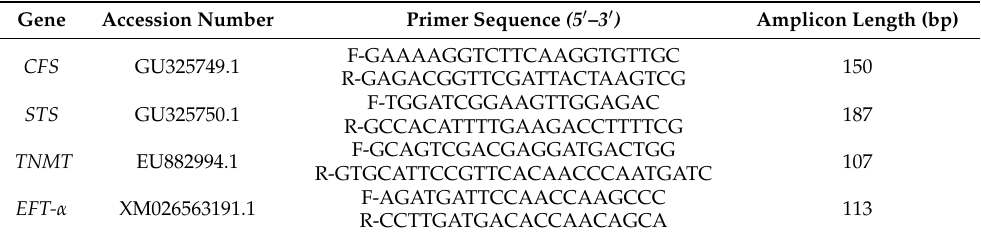
Table 1. The reference gene was Elongation factor 1-alpha ( EF1 -a) (Table 1). Table 1. Primers for target genes used for the quantitative real time polymerase chain reaction